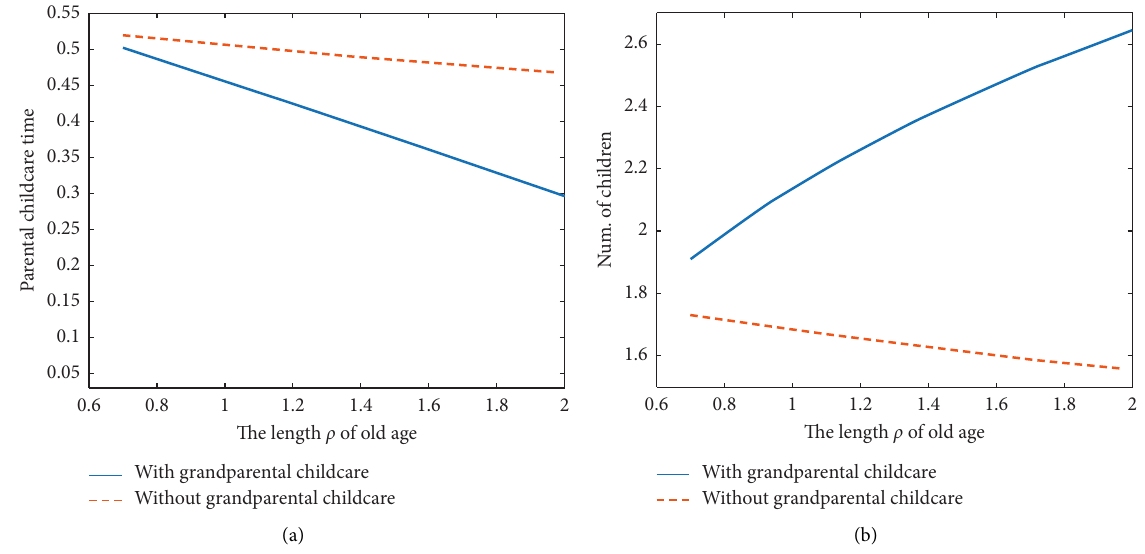
Figure 3: Simulation study of the DGE model with/without considering intergenerational childcare (i.e., grandparental childcare). (a) The association of length ρ of old age with parental childcare time; (b) the association of length ρ of old age with number of children of their offspring.